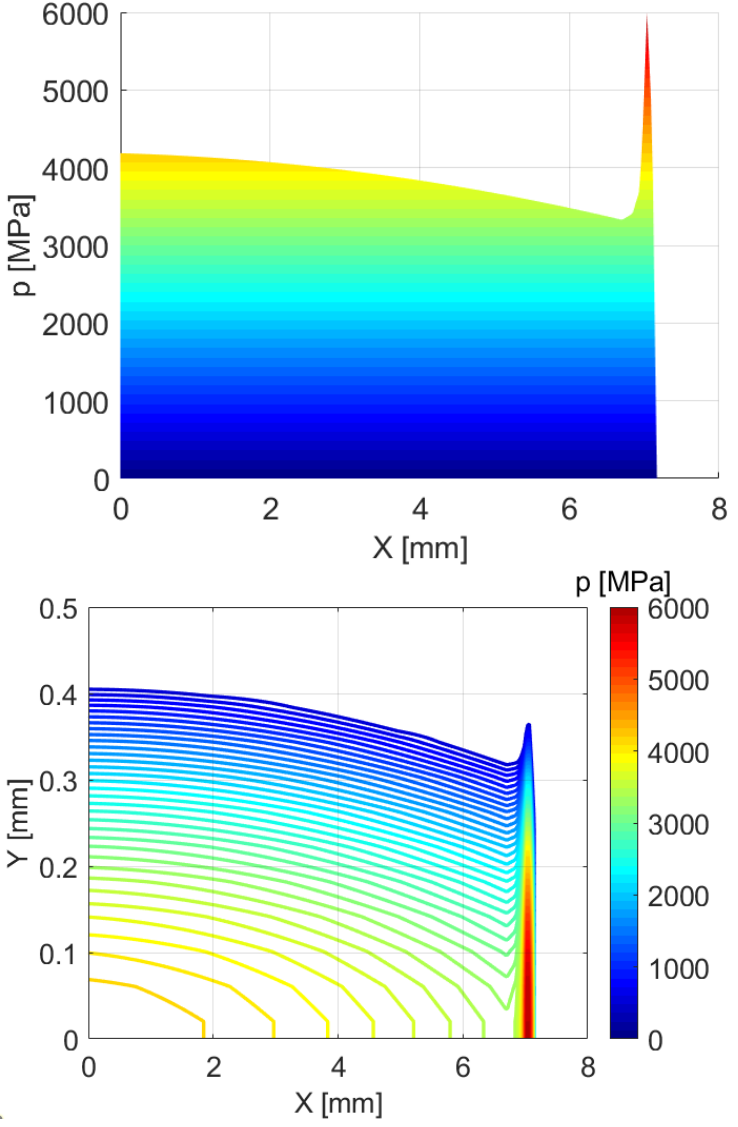
Figure 8. Pressure distributions for the crowned roller and inner race